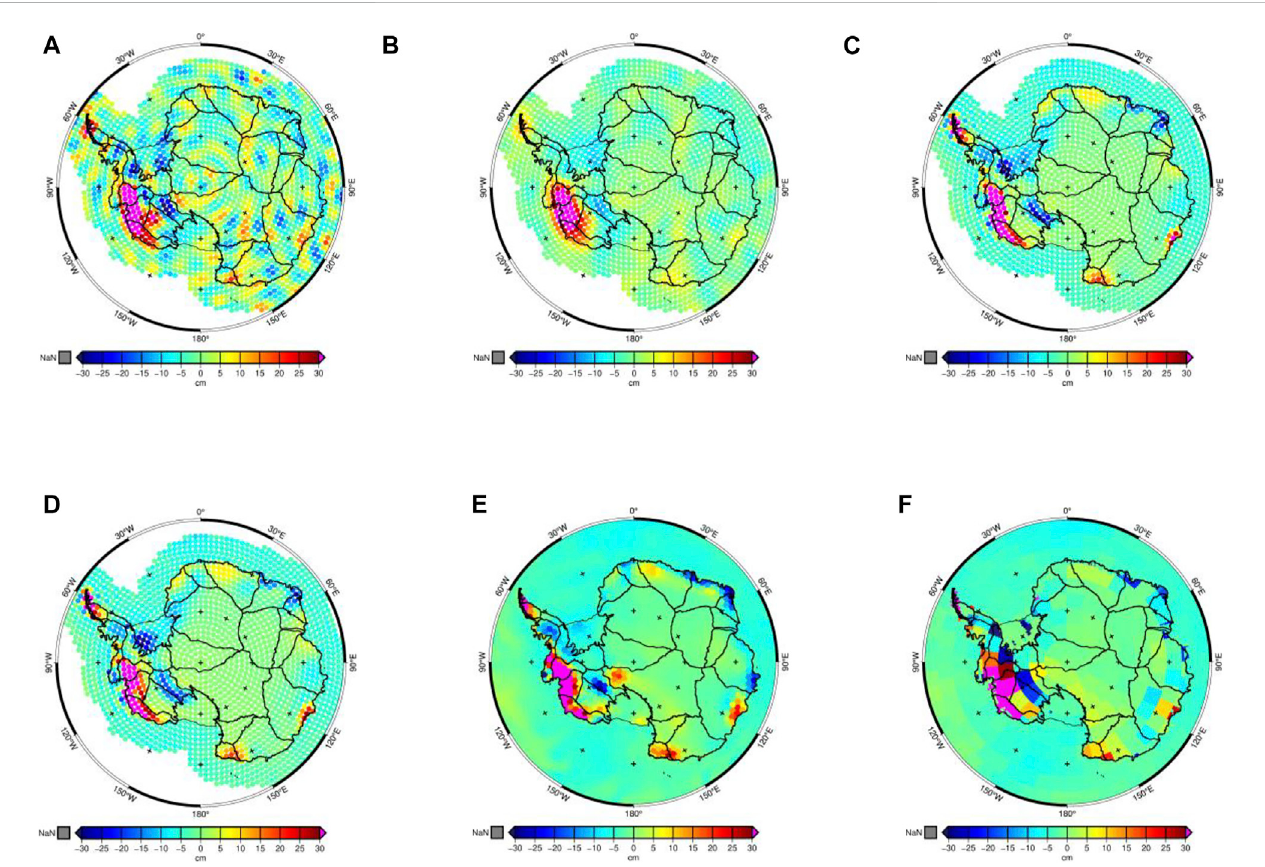
FIGURE 6 Mass change signals in June 2004. (A) and (B) : P4M6 with Gaussian 100 and 200 km; (C) and (D) : the correspondent mascon solutions; (E) and (F) : CSR and JPL mascon solutions.